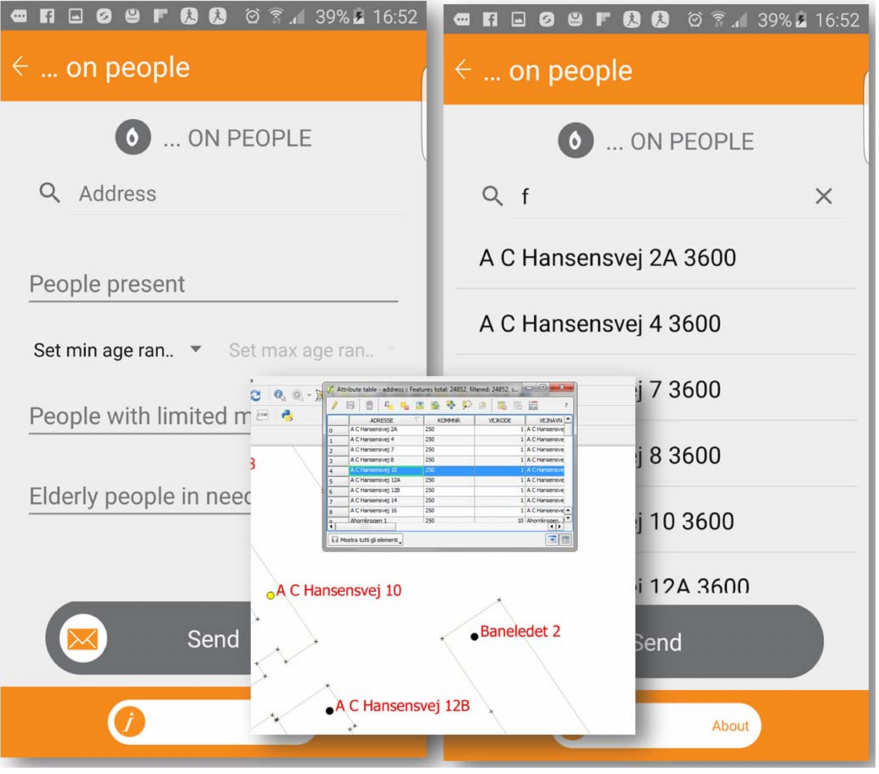
Figure 5. Details required for safety or specific rescue services.